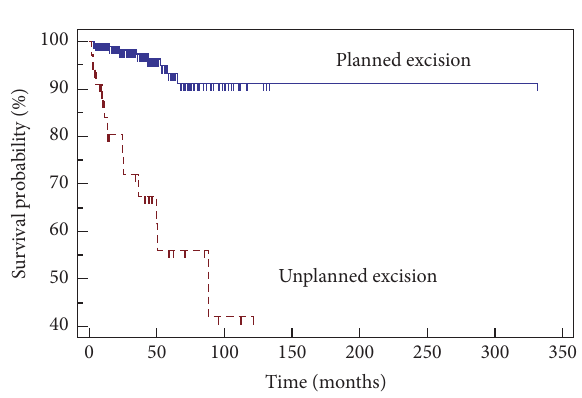
Figure 1: Local recurrence-free survival and excision